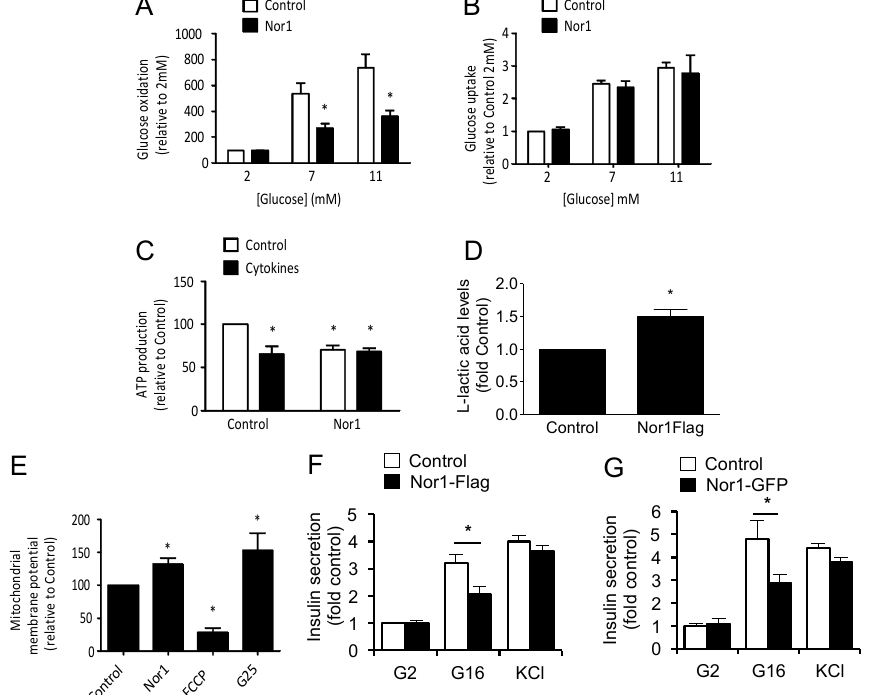
Figure 2. Nor1 impairs glucose oxidation and insulin secretion in beta cells. Glucose oxidation ( A ) and glucose uptake ( B ) were measured in INS832 / 13 cells transfected with Nor1-Flag (black bars) or a control flag vector (white bars) and exposed to 2, 7, or 11 mM glucose for 45 min. ( C ) ATP levels measured in INS832 / 13 cells transfected with Nor1-Flag or a control flag vector and cultured at 11 mM glucose in the presence (black bars) or absence (white bars) of cytokines. ( D ) Lactic acid levels were measured in cells transfected with Nor1-Flag or a control flag vector and cultured at 11 mM glucose. ( E ) Mitochondrial membrane potential was determined by evaluating JC-1 fluorescence in INS832 / 13 cells transfected with Nor1-Flag or a control flag vector. Cells were exposed to 20 µ M FCCP for 15 min and 25 mM glucose for 4 h (G25) as negative and positive controls, respectively. ( F ) Insulin secretion was measured in cells transfected with Nor1-Flag (black bars) or a control flag vector (white bars) at low (2 mM glucose, G2) or stimulatory glucose concentrations (16 mM glucose, G16) by ELISA. KCl (35 mM) was used to maximally depolarize the cells. Results are expressed as fold control (control vector at 2 mM glucose). ( G ) Insulin secretion was measured in cells transfected with Nor1-GFP compared to GFP control as described in ( F ) above. All results are represented as mean ± SEM of three separate experiments. * p < 0.05 versus control.